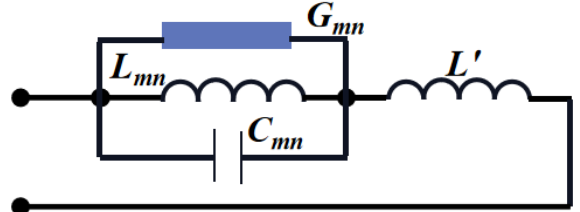
Figure 2. The simplified equivalent circuit model (established when w mn is isolated from all other resonant frequencies).